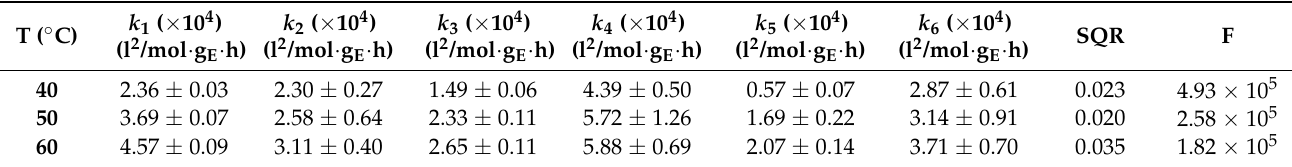
Table 2. Kinetic constants from runs at constant temperatures with their standard errors and goodness- of-fit parameters.